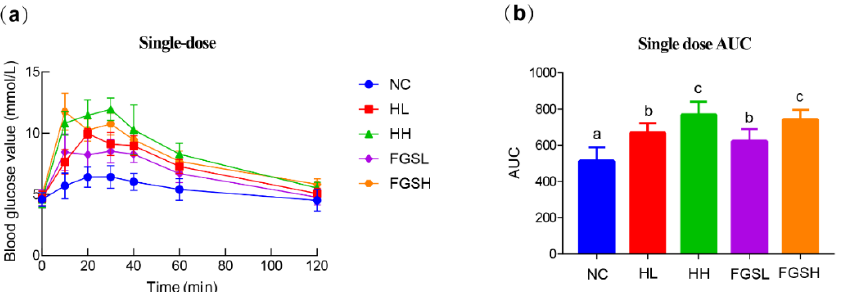
Figure A2. Honey and sugar feeding to mice affected glucose homeostasis over 2 h. Blood glucose value changes ( a ) and the AUC ( b ) were monitored in the single dose test. Data are expressed as the mean ± SD. Graph bars with different letters on top correspond to statistically significant results ( p < 0.05) based on a one-way ANOVA. In contrast, bars with the same letter correspond to results that showed no statistically significant differences.